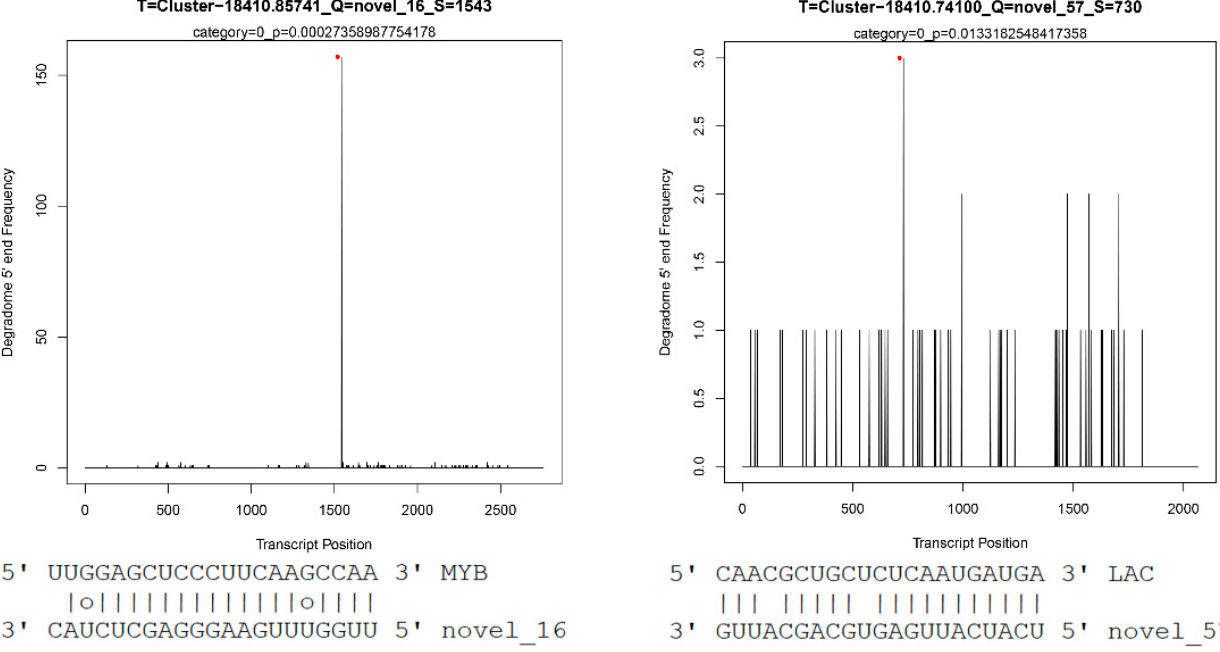
Figure 7. Target plots of novel_16 ( left ) and novel 57 ( right ). The target genes of novel_16 and novel_57 are Cluster- 18410.85741 and Cluster-18410.74100, respectively. The horizontal coordinate corresponding to the red dot indicates that the miRNAs cleave the target genes at that position.